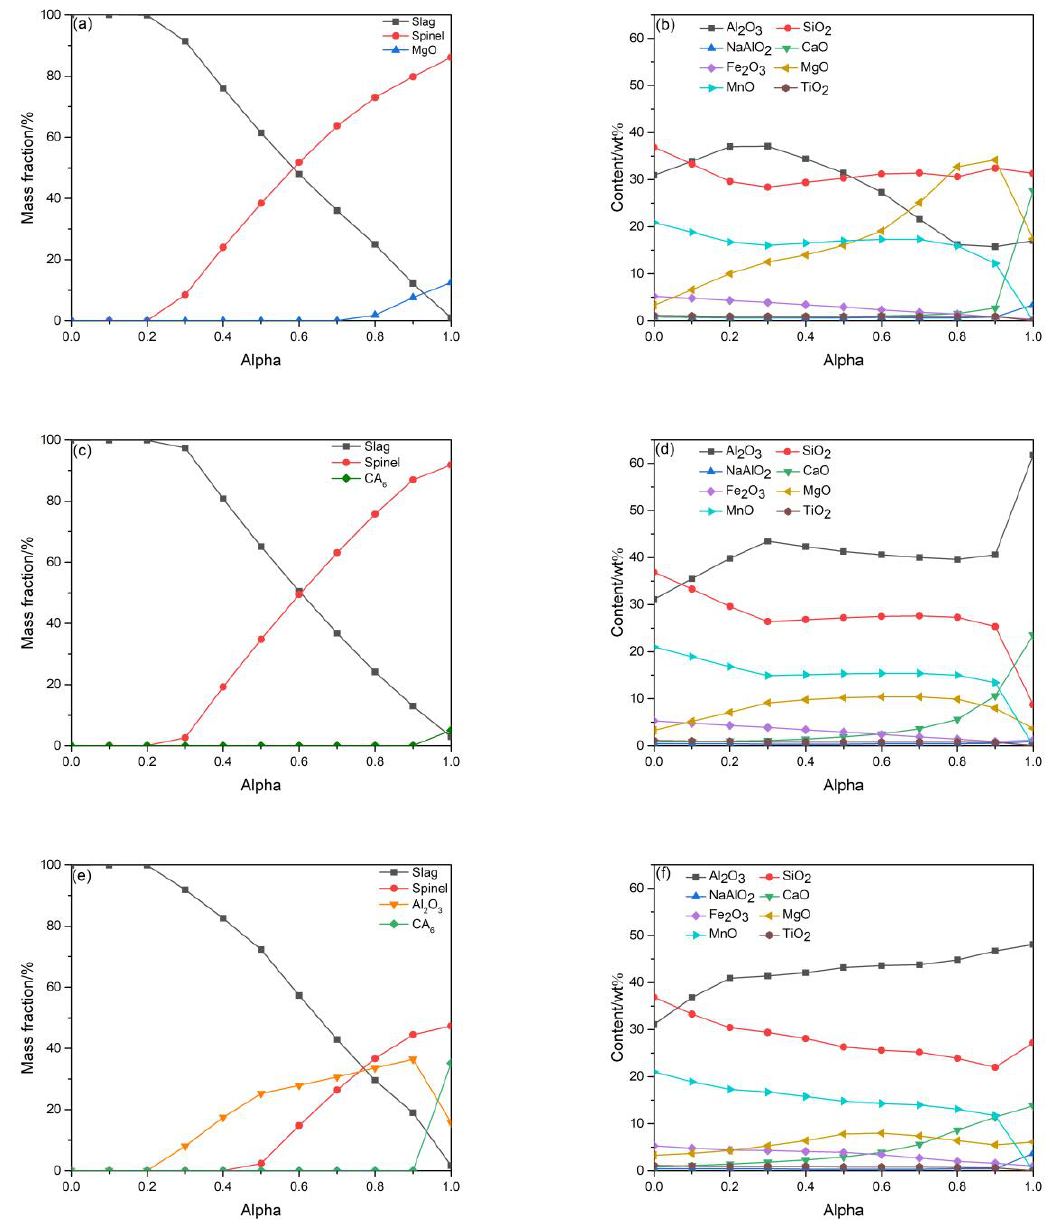
Figure 10. Predicted phase composition of refractory matrix and slag composition in contact with molten slag at 1600 ◦ C: ( a , b ) G0, ( c , d ) G4, and ( e , f ) G8. The microstructure of the corroded samples with slag heated at 1600 ◦ C for 3 h is shown in Figure 11. The results of energy-dispersive spectrum analyses of different zones are listed in Table 5. In spite of a little difference in contrast, it can still be seen that the molten slag penetrated along the matrix into the original layer of refractories (the right side in Figure 11) accompanied by the dissolution of corundum aggregates. The incom- pletely eroded coarse corundum particles appeared at a distance of about 1.5 cm from the boundary of sample G0 (Figure 11a), but smaller corundum particles were located closer to the boundary of sample G8 (Figure 11d), which coincided with the prediction shown in Figure 10e. The slag penetration of sample G8 was the most serious because of the silica derived from the slag in the regions far away from the boundary (Zones 7 and 8, as seen in Table 5). Higher Mn and Fe content in the region near the boundary of sample G4 (Zone